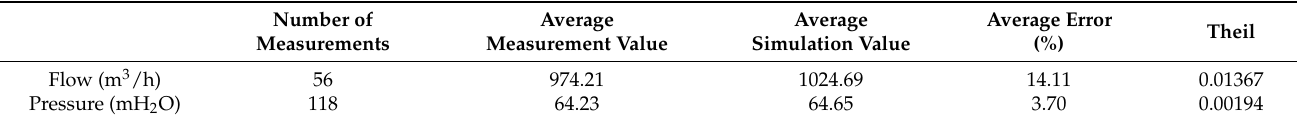
Table 3. Results of compliance analyses for the whole water supply system.